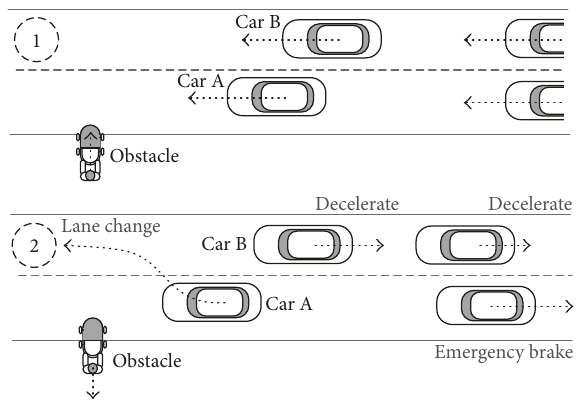
Figure 1: Emergency Lane Changing Situation